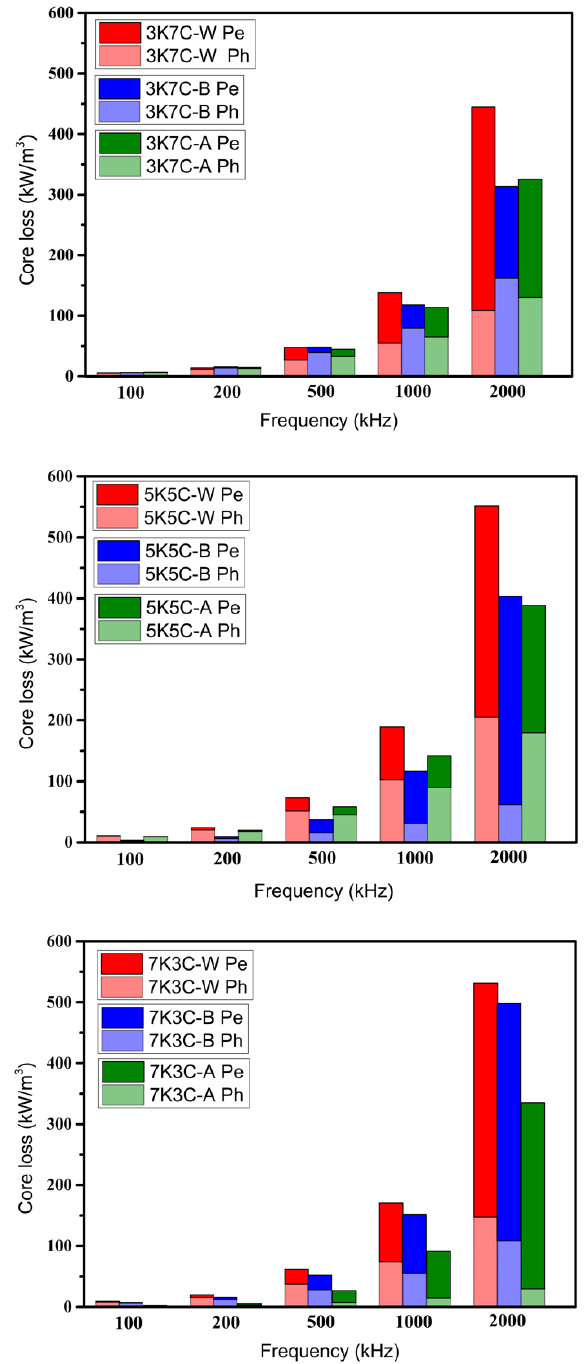
Figure 9. Effect of the heat-treatment procedure on the power losses of the toroidal bodies.